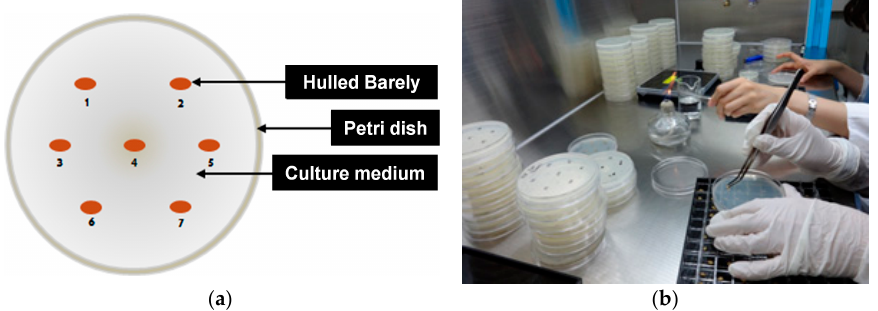
Figure 2. ( a ) Location and ( b ) configuration of kernels on Petri dish to culture Fusarium of hulled barley.